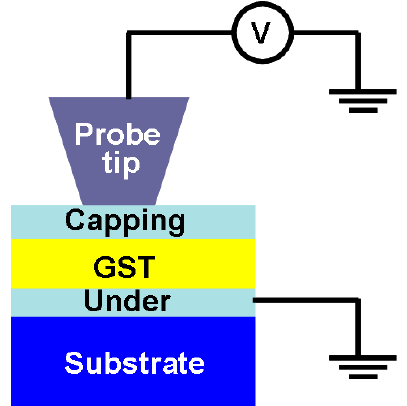
Figure 3. Schematic of phase-change electrical probe device.